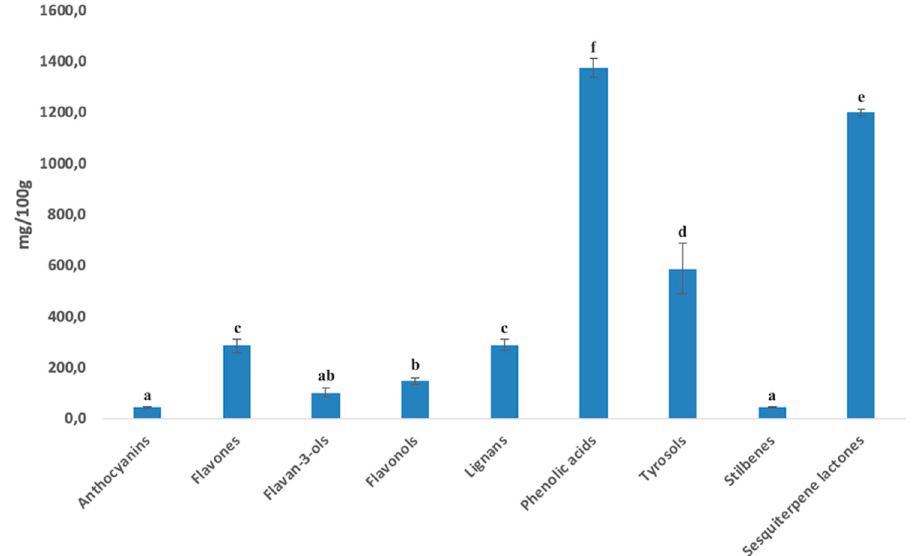
Figure 1. Semiquantitative cumulate values (expressed as mg·100g − 1 DM) for the different phenolic classes and for total sesquiterpene lactones, as resulted from UHPLC-quadrupole-time-of-flight (QTOF)-MS profiling.